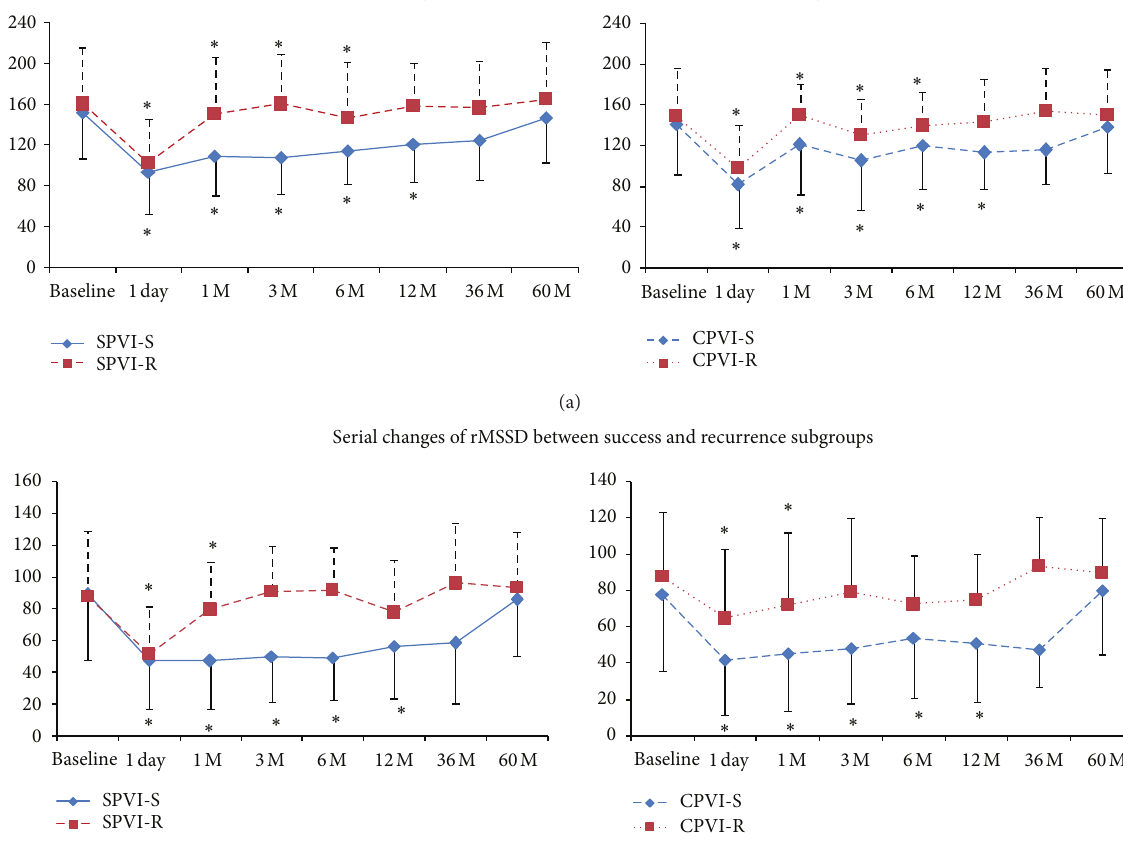
PVI, denervation may be another common mechanism underlying different procedures for